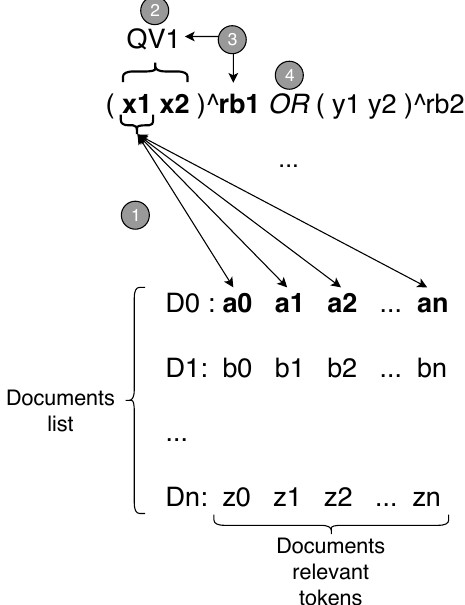
Figure 4. Neighbourhood score computation steps, composed by the neighbourhood pair computing, intermediate sub-query value computation, recency boost, and final score